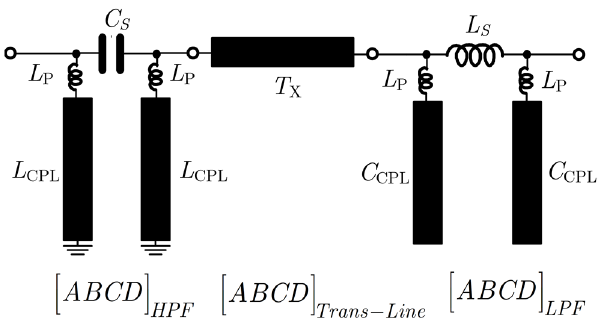
Figure 4. The schematic of the proposed UWB-BPF.